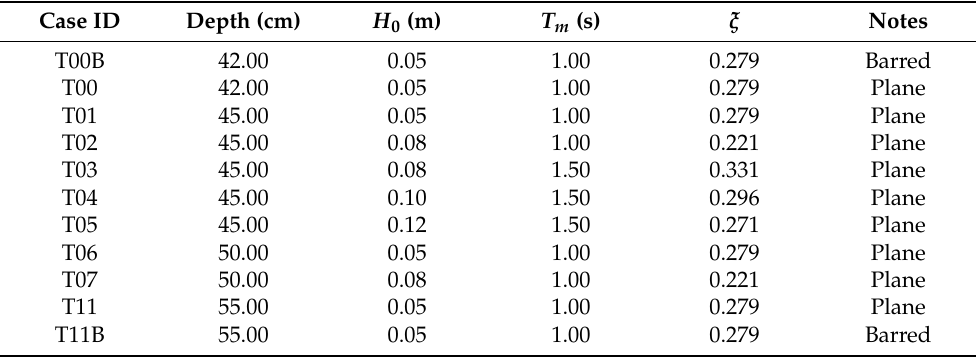
Table 2. Experiment